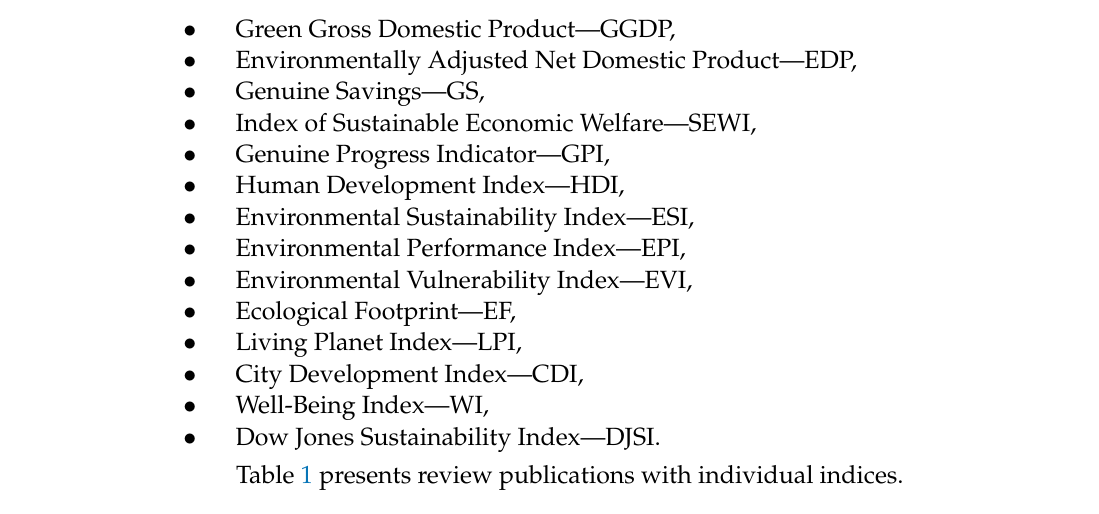
Table 1. Sustainability indices included in individual